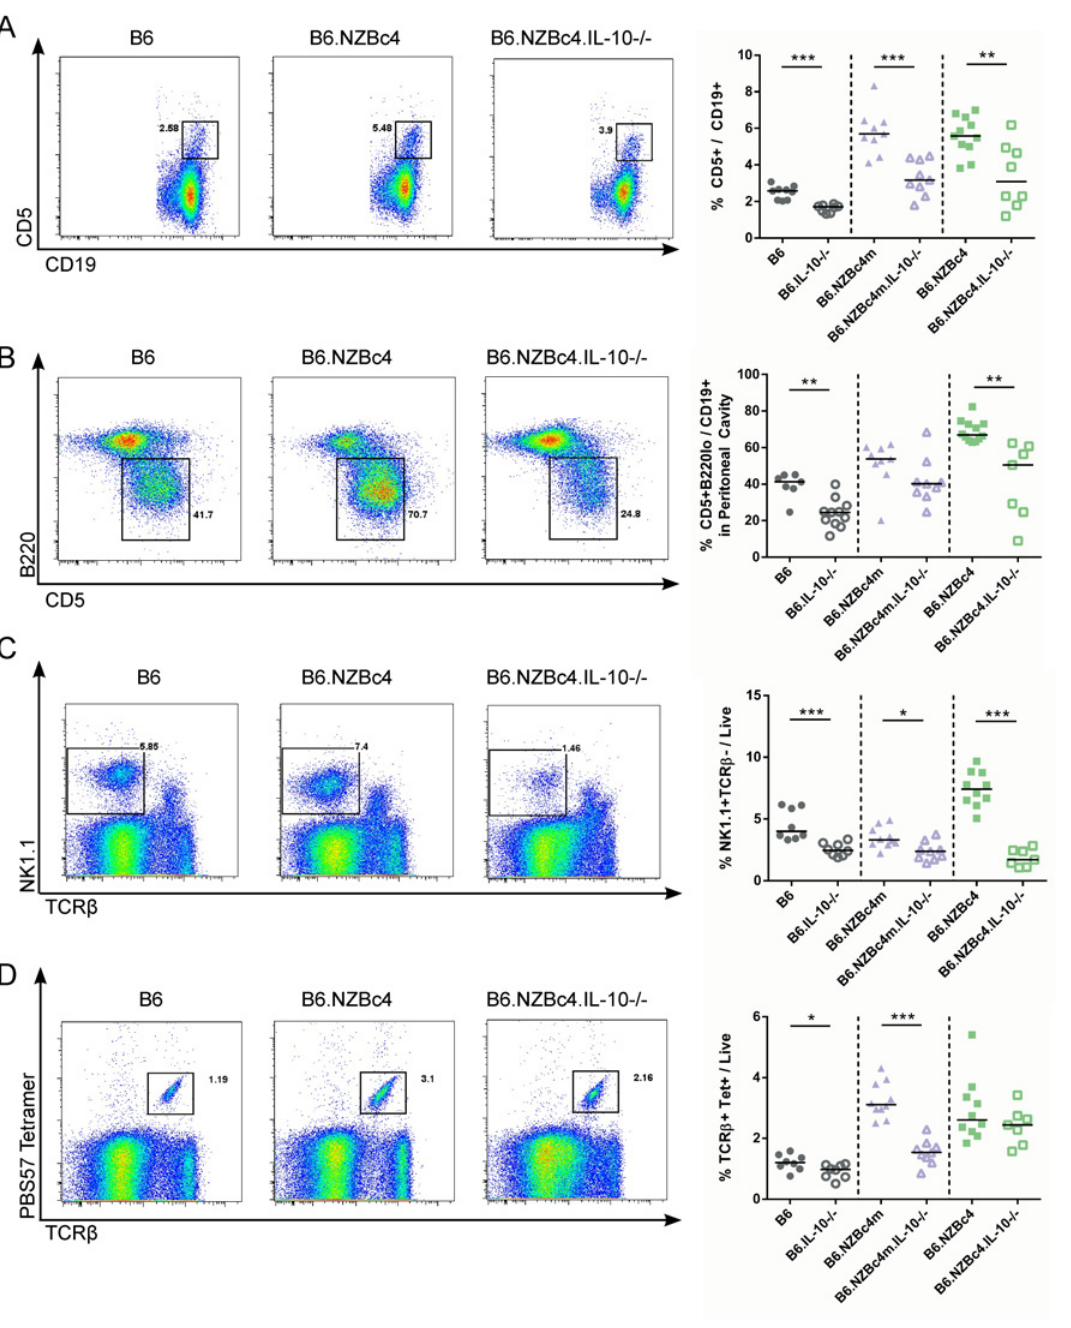
Fig 4. The expansion of CD5 + B cells, NK and NKT cells is impacted by the loss of IL-10. The frequency of splenic and peritoneal cells was measured in 4 month old mice by flow cytometry. Representative gating and results for splenic CD5 + B cell (A), peritoneal CD5 + B cell (B), NK cell (C) and NKT cell frequencies (D). Each point represents a single mouse, with the lines for each group representing the median. Statistical analyses were carried out using a Mann-Whitney U test between homozygous and IL-10 knockout animals of the same genetic background. * P < 0.05, ** P < 0.01, *** P <